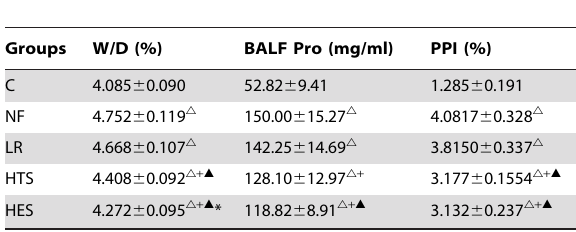
Table 3. Measurements of W/D, BALF pro, PPI in the five groups (8 animals in each